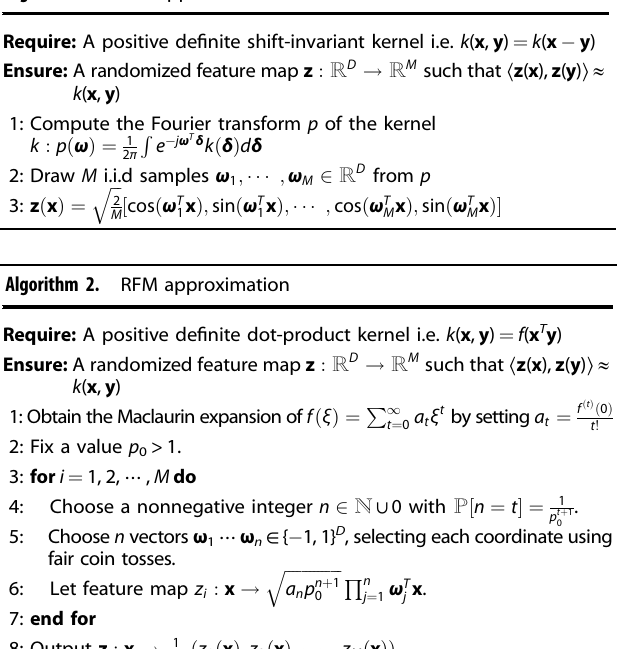
Algorithm 1. RFF approximation